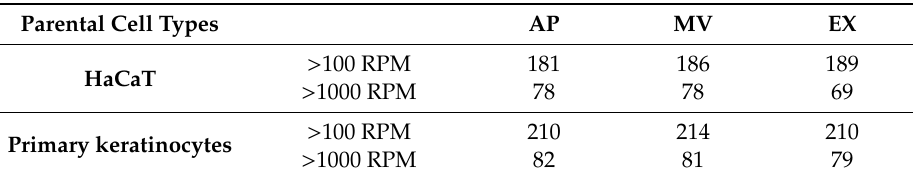
Table 1. Number of highly abundant extracellular membrane vesicle (EV) miRNAs with reads per million (RPM) greater than 100 and greater than